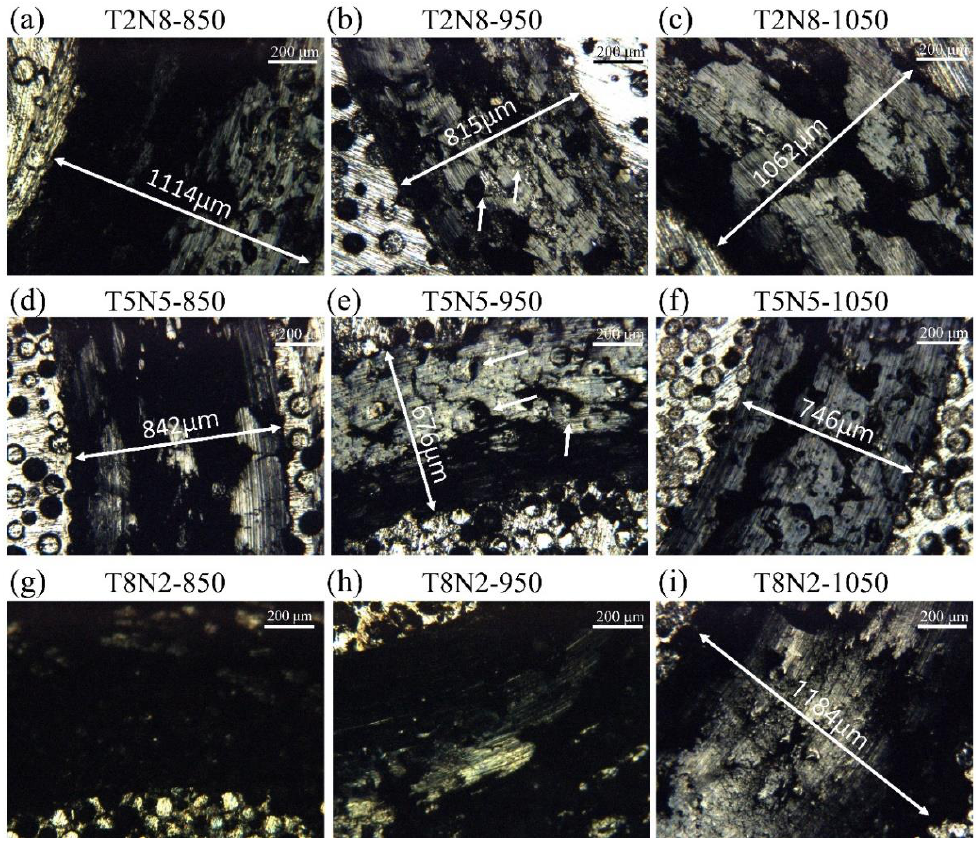
Figure 9. LM micrographs of T2N5, T5N5, and T8N2 after wear test. ( a ) T2N8-850, ( b ) T2N8-950, ( c ) T2N8-1050, ( d ) T5N5-850, ( e ) T5N5-950, ( f ) T5N5-1050, ( g ) T8N2-850, ( h ) T8N2-950, and ( i ) T8N2-1050.